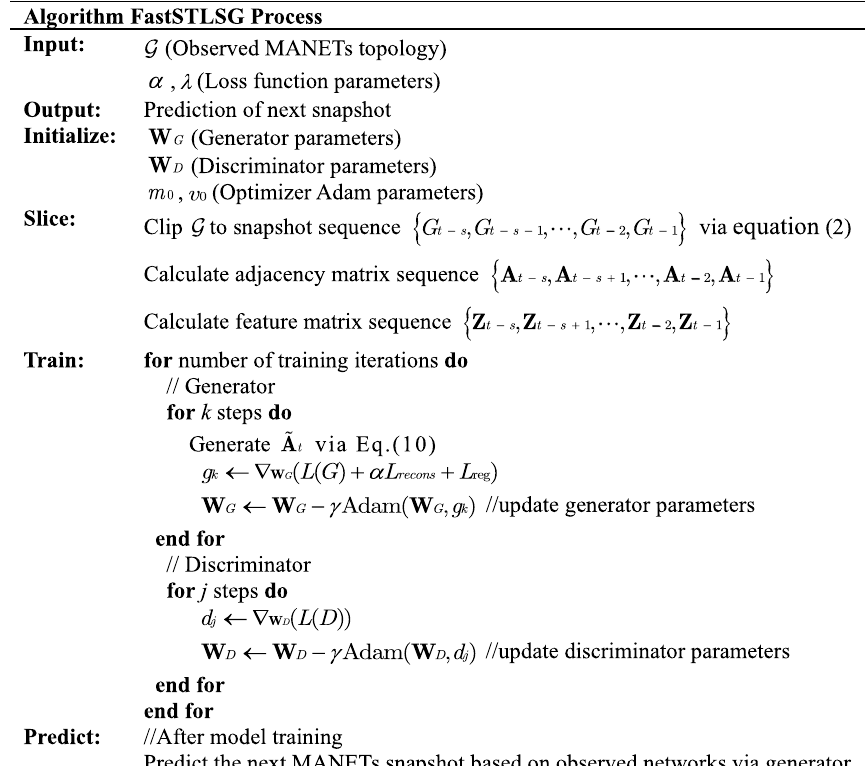
Table 2. Algorithm FastSTLSG